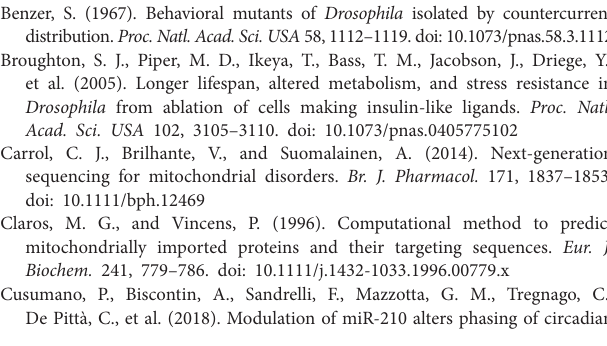
muscles and brains, illustrating the distribution and morphology of mitochondria, are represented. (D) dCOA8 mRNA levels, expressed as relative quantity